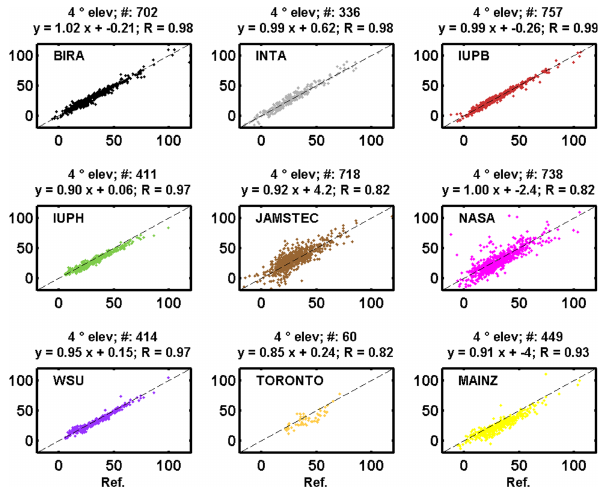
Fig. 6. Scatter plots of HCHO DSCDs (10 15 moleccm − 2 ) mea- sured by each instrument compared to the campaign reference data set (see text), for the case of measurements at the 4 ◦ elevation an- gle. Statistical parameters derived from the regressions (number of points #, linear regression equation and correlation coefficients R ) are given on top of each subplot. The dashed line is the y = x line.